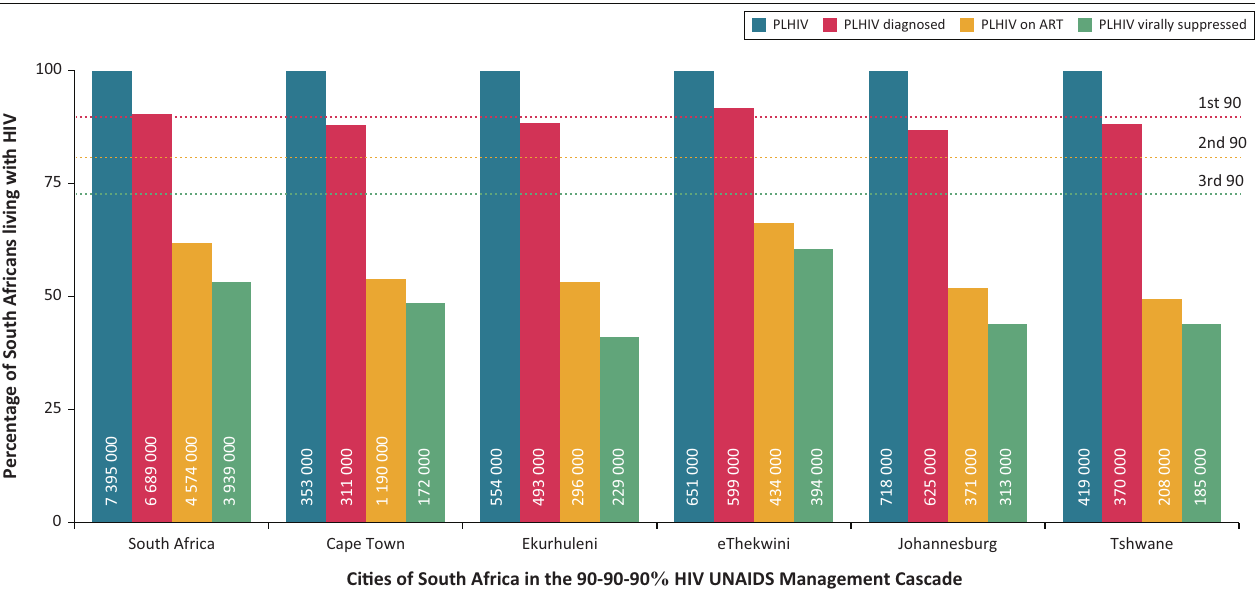
FIGURE 1: The 90-90-90 % -HIV treatment cascade in South Africa and five of its metropolitan districts in 2018.